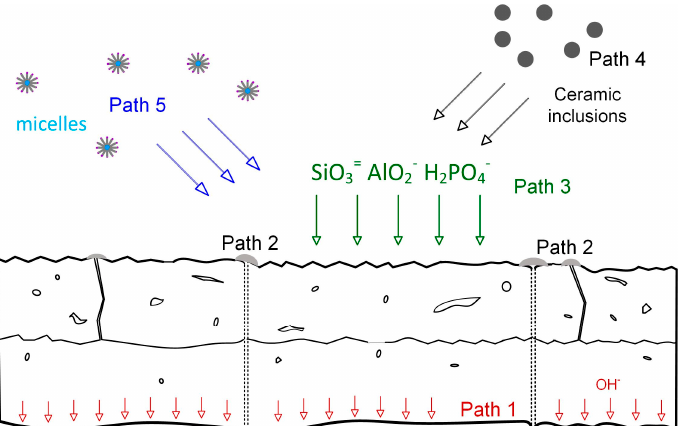
Figure 3. Schematic diagram of five growth paths and their growing species. Path 1 is the path of hydroxyl ion oxidizing the metal substrate; path 2 involves the deep and shallow discharges melting oxide and freezing again; path 3 is the oxyanions adsorption and deposition; path 4 is the incorporation of ceramic particles; path 5 involves organic polymeric colloids or dye micelles incorporation.